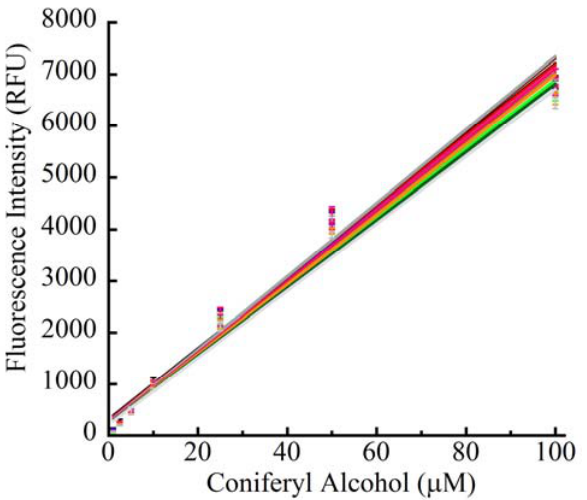
Figure 11B. Linearity of CA photostability. This figure shows the negligible effects on linearity between 1.0 to 100  M CA over the various interrogation times. The correlation of coefficient, r 2 was 0.985 ± 0.001 for n = 14; an error of <0.2% from CA samples subjected to 42 cycles of excitation/emission over a 24 h period. All other conditions and the colored tracings representing measurements between 5 and 1440 min are the same as those described for Figure